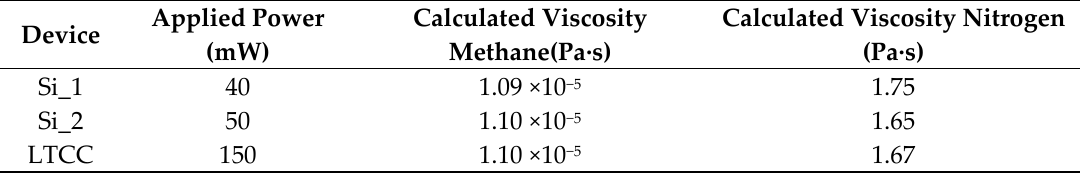
Figure 4. Experimental differential pressure data once the heater is switch off, Gas: Nitrogen. Table 3. Calculated dynamic viscosity by viscometer for Methane and